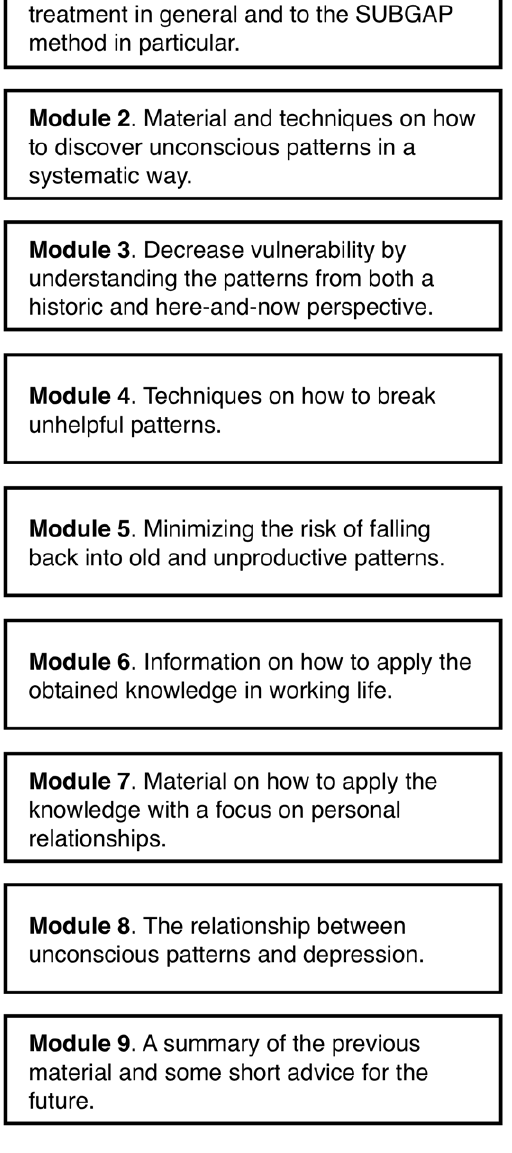
was not included in the model. Error terms across time were modelled with a first-order autoregressive covariance structure with heterogeneous variances. Differences in average rates of growth between the two groups were examined by a fixed effects interaction between group and time. Between-group differences at post-treatment were analysed using independent t -tests. Power analysis indicated an 89% chance of detecting a between-group effect size of d = 0.60 ( a level = 0.05). To investigate recovery after treatment and at follow-up, the BDI-II was used. Recovery was defined as a post-treatment BDI-II score # 10. This definition is in line with previous clinical trials on depression (e.g. [23,24]). Participants who did not provide post- treatment data or follow-up data were classified as non-recoverers.